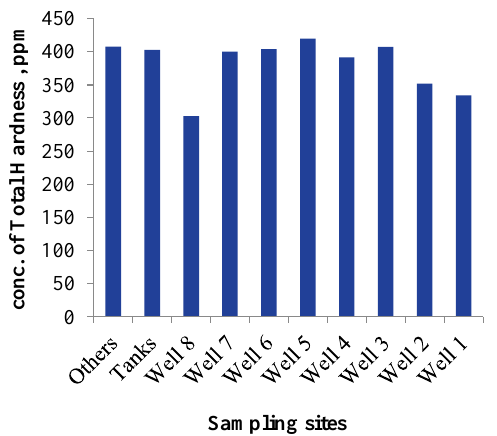
Figure 13. The average of Total Hardness (mg/l) in well, Tanks and others 2008-2013 Fluctuation in the amount of rain and leachate drainage from farming or agricultural fields and using wells water for gardening and farming can affect the total hardness of groundwater. Our result was similar to previous results in Rey which showed medium concentration of total hardness was 375 mg/l. 29 On the other hand, water hardness can decrease cardiovascular diseases (CVD). Mg and Ca in hard water can protect from CVD mortality. 30-32